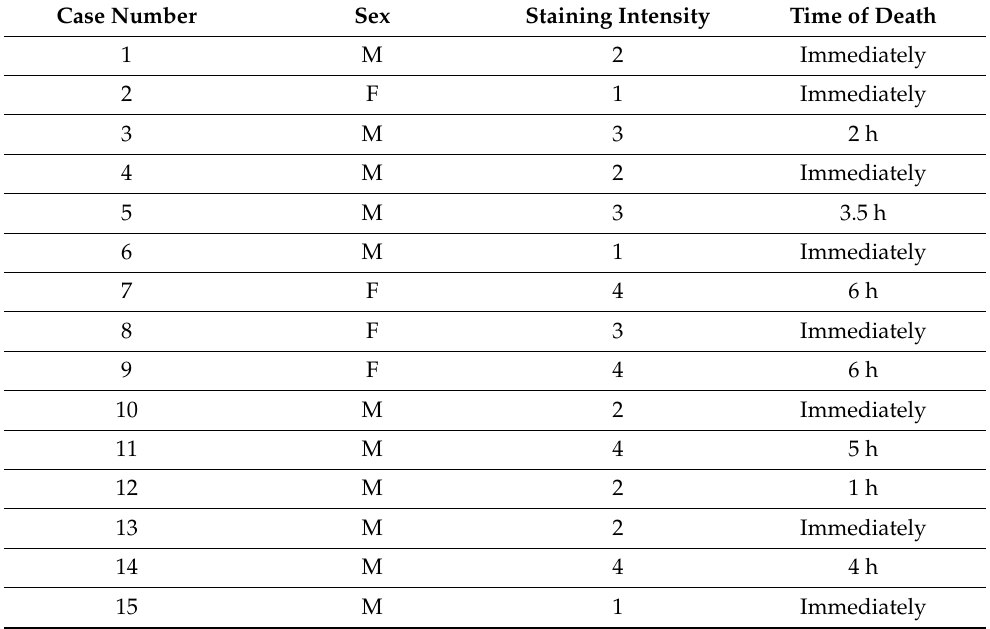
Figure 1. FOXO3a expression in the analyzed cerebral samples (red arrows). The scale bar showed 250 µ m in distance. ( A ) FOXO3a is negative (intensity score 0) (100 × ), ( B ) FOXO3a is positive (Intensity score 1) (100 × ), ( C ) FOXO3a is positive (intensity score 2) (100 × ), ( D ) FOXO3a is positive (intensity score 3) (100 × ), ( E ) FOXO3a is positive (intensity score 4) (100 × ). Table 1. This table shows the results of the semi-quantitative analysis of the IHC reaction in the cerebral section of the 15 cases of TBI. Qualitative and statistical differences were seen concerning the time of